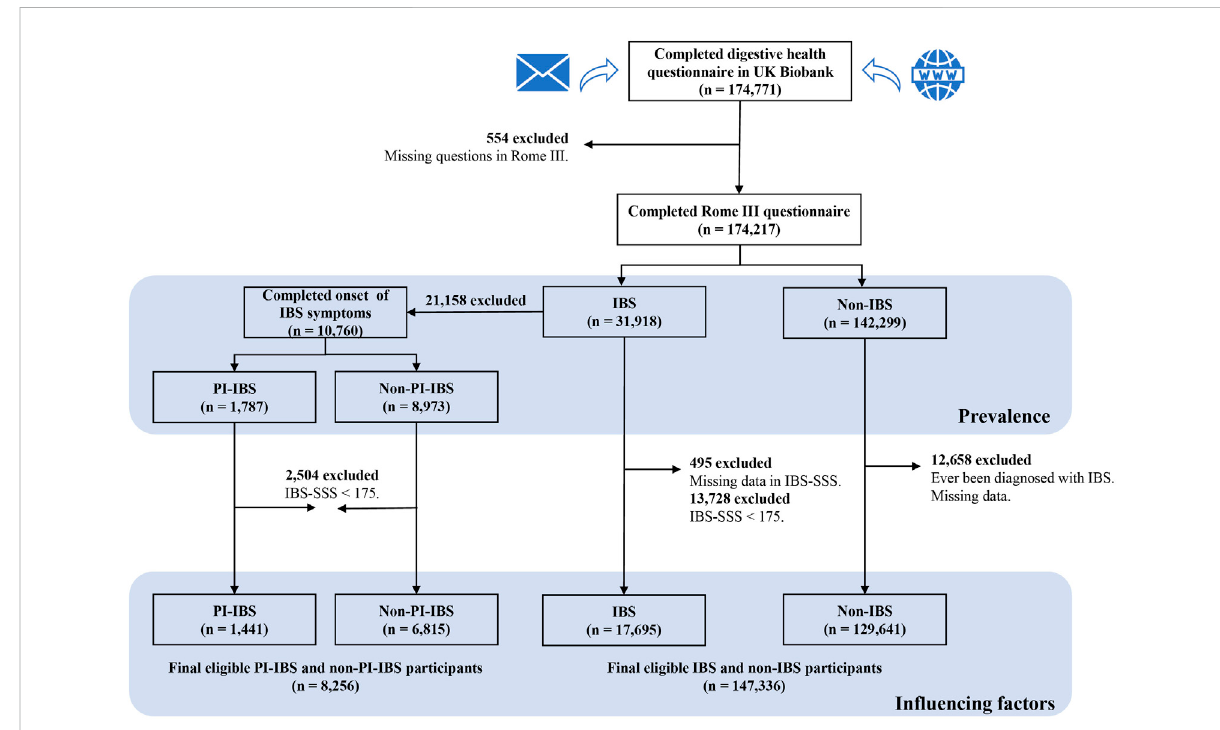
FIGURE 1 Flowchart of participant inclusion and exclusion. IBS, irritable bowel syndrome; non-IBS, participants without IBS; PI-IBS, post-infectious IBS; non-PI-IBS, participants without PI-IBS but with IBS; and IBS-SSS, IBS symptom severity